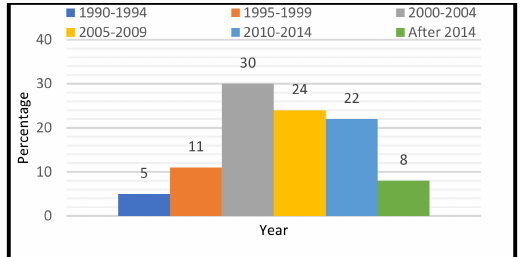
Figure 6. Length of involvement in the vegetable seed